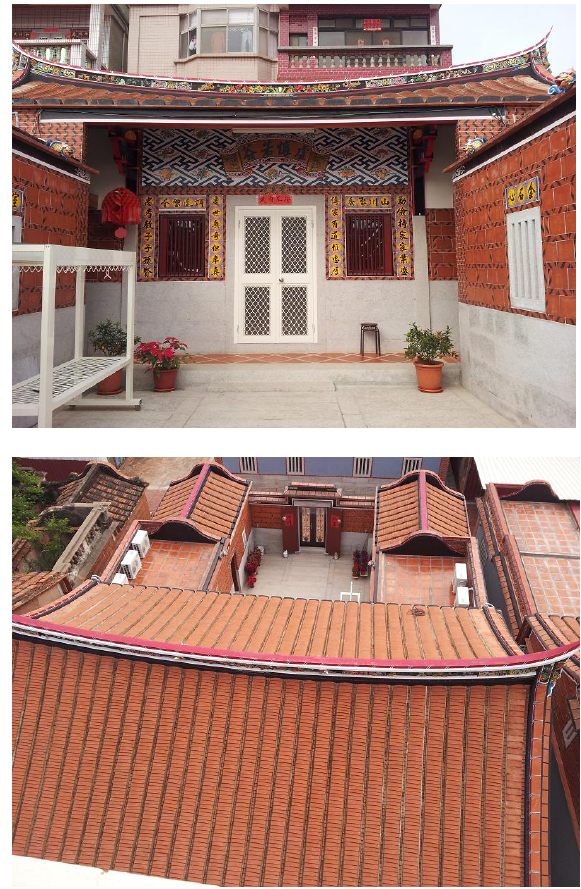
Figure 2. Residential house in Jinning Town, Kinmen